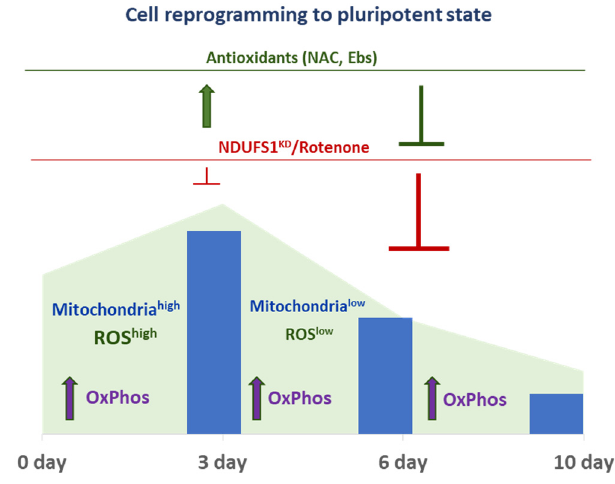
Figure 6. Summary diagram showing dynamics of mitochondria content and ROS generation during the course of reprogramming of MEFs to iPSCs. Inhibiting CI of ETC via Ndufs1/Ndufb10 knockdown or treatment with rotenone are well tolerated during the first 3 days, however, strongly suppresse cell reprogramming during intermediate and late stages of this process. ROS scavenging by antioxidants ameliorates cell reprograming during the first 3 days, however, it suppresses the process when applied at later stages.